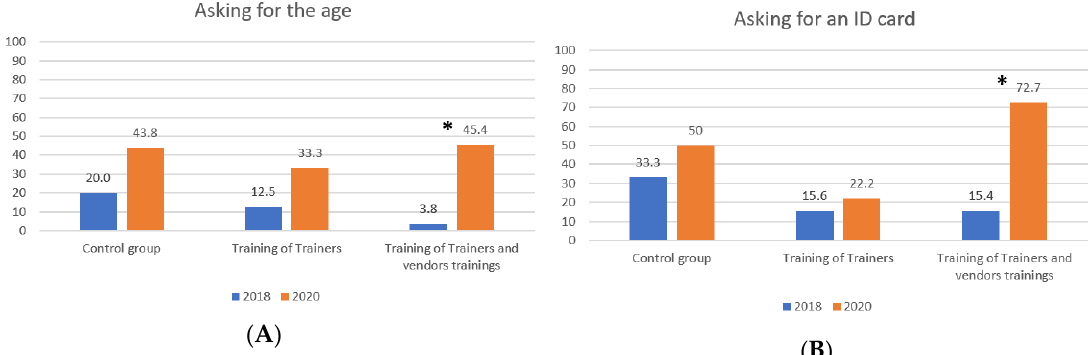
Figure 1. Proportion of supermarket visits by year and type of training. ( A ) Proportion of supermarket visits where minors were asked for their age and ( B ) proportion of supermarket visits where vendors asked for an ID card. * = statistically significant differences were found.